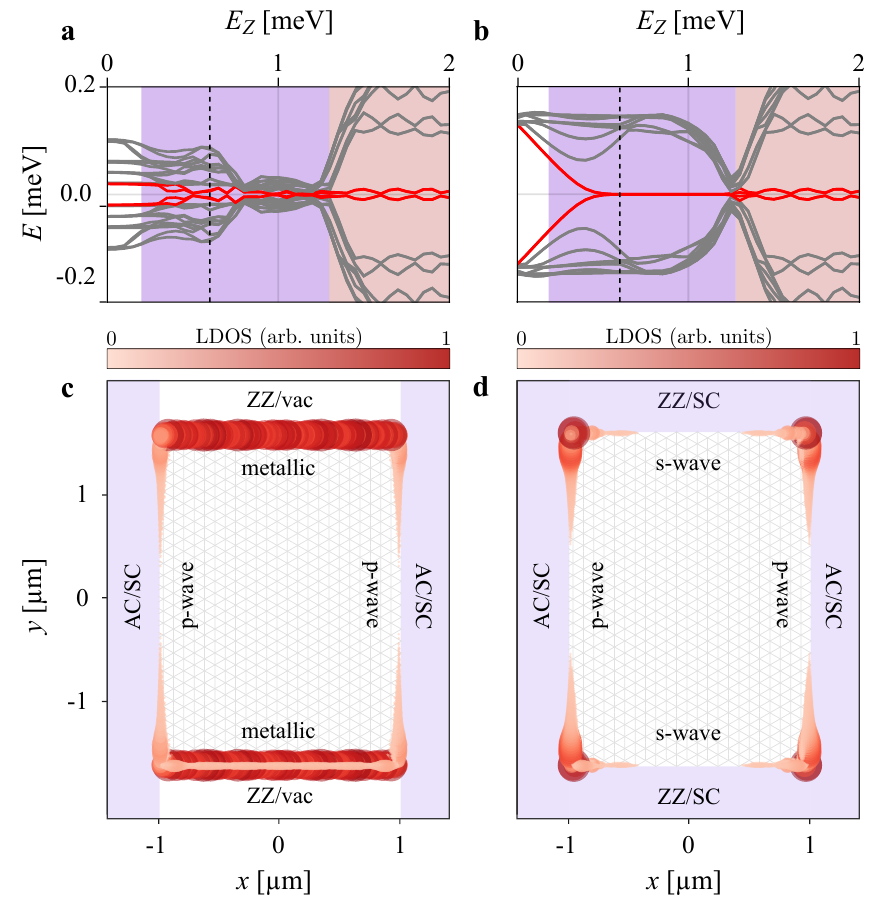
Figure 4: (a,b) Low-energy spectrum as a function of Zeeman splitting E angular sample in the two configurations A and B of Fig. 1 and with the same param- eters as Fig. 3. Background colors match Fig. 3. (c,d) Local density of states across the sample corresponding to the four lowest eigenstates [ red curves in (a,b) ] at the vertical dashed line in (a,b) (p-wave armchair phase). In configuration A (a,c), the zigzag edges are metallic, so the MBSs become spatially delocalized and merge into a quasi-continuum of zigzag states, while in configuration B (b,d) zigzag edges have a trivial s-wave gap, so the MBS remain localized at the